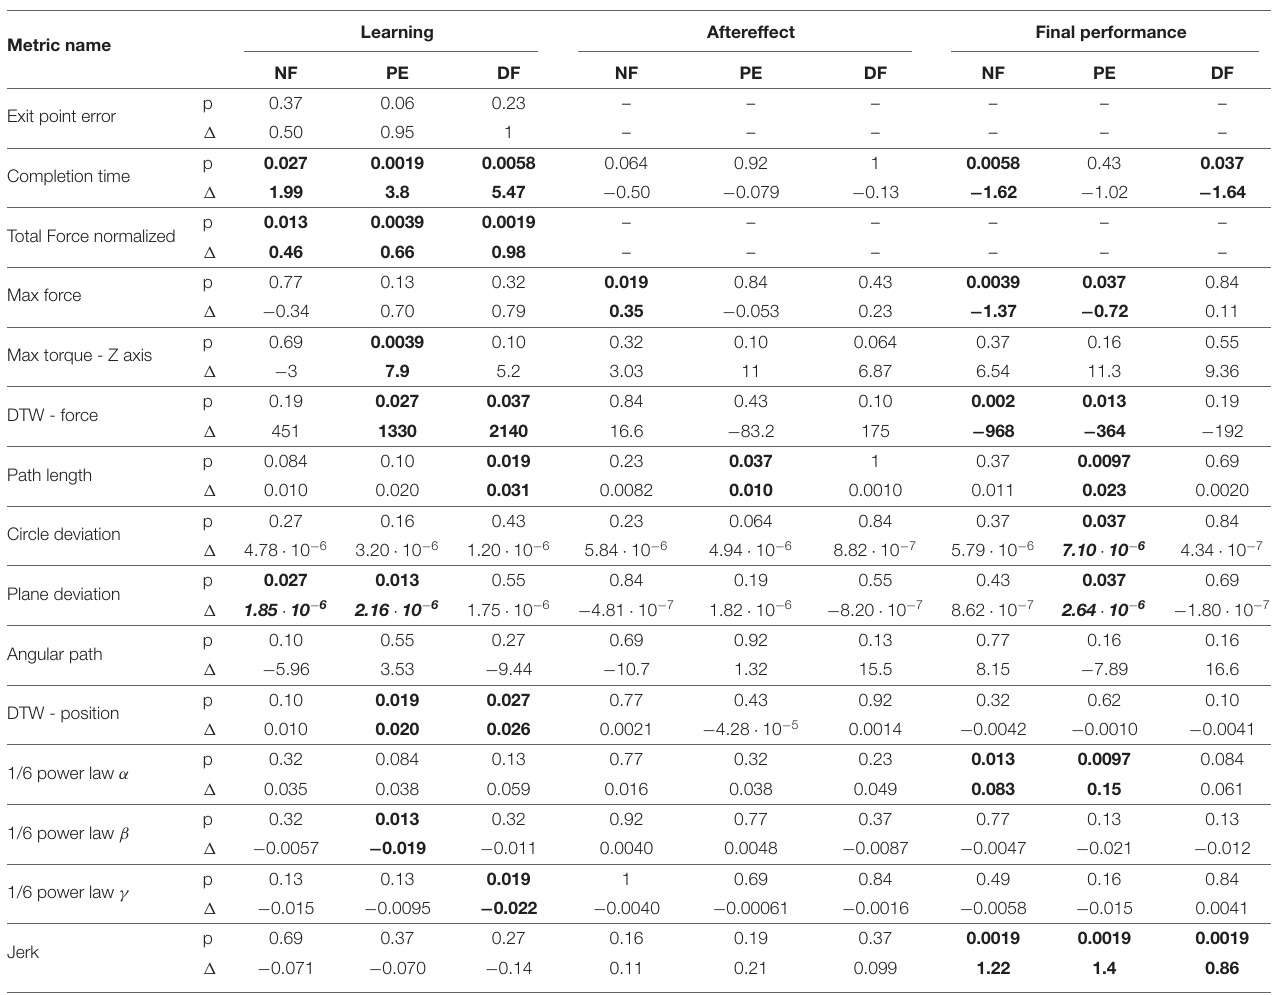
TABLE 1 | Statistical analysis—Wilcoxon sign